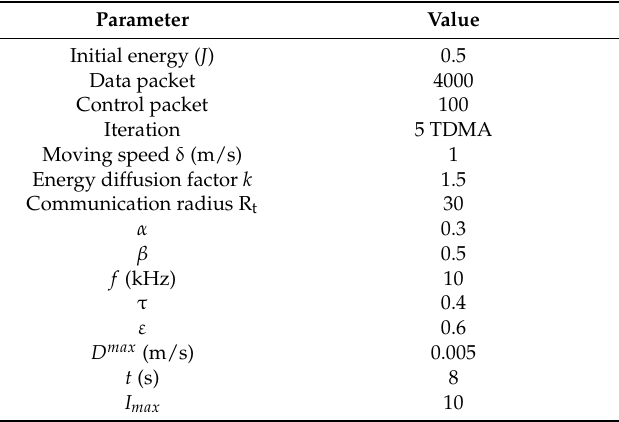
Table 1. Simulation